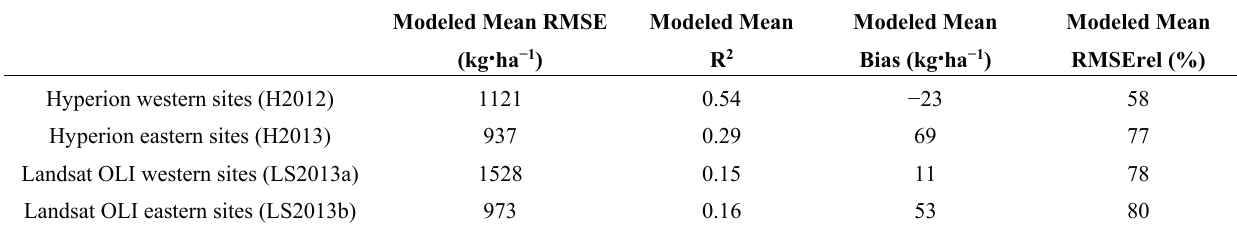
Table 1. Cross validated modeling performance of the different feature sets averaged over all